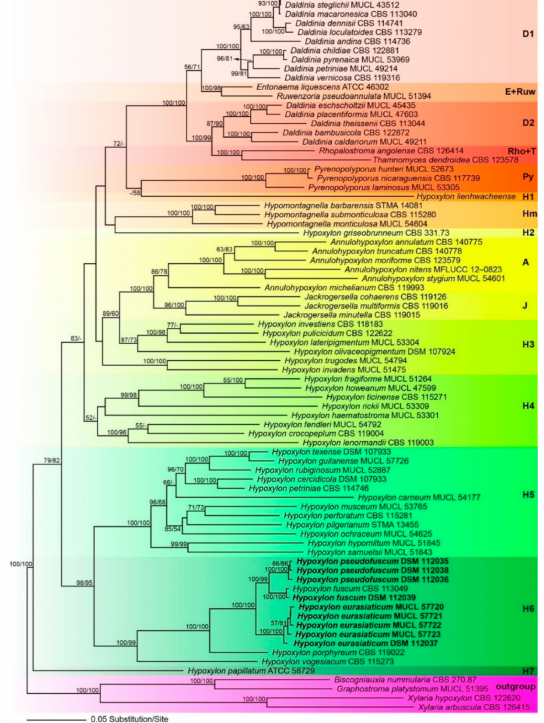
Figure 1. Phylogram of the best ML trees (lnL = − 72650.213864) revealed by RAxML from an analysis of the combined ITS–LSU– rpb2 – tub2 matrix of selected Xylariales. Strains in bold were sequenced in the current study. ML and MP bootstrap support above 50% are given at the first and second positions, respectively, above or below the branches. Different background colours have been applied to highlight the major